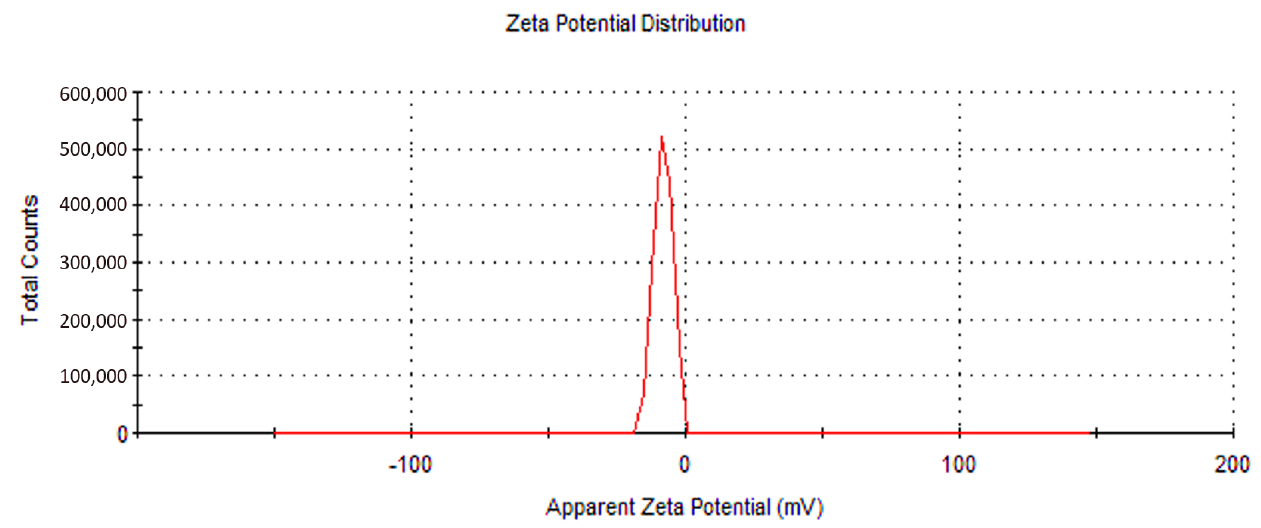
Figure 8. Zeta potential distribution CCsMFO nanocomposite curve.